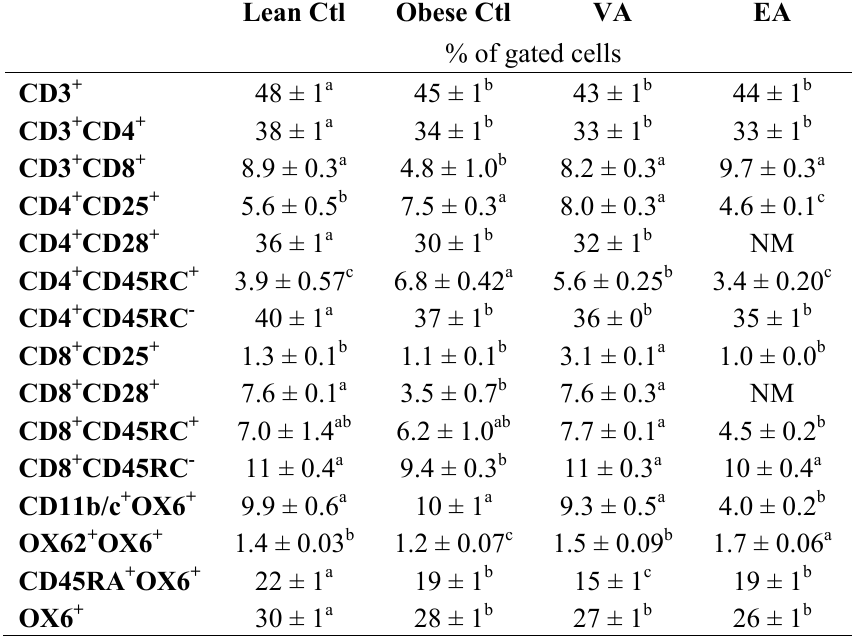
Table 4. Splenocyte phenotypes of lean Ctl rats and obese JCR:LA- cp rats fed VA, EA or Ctl